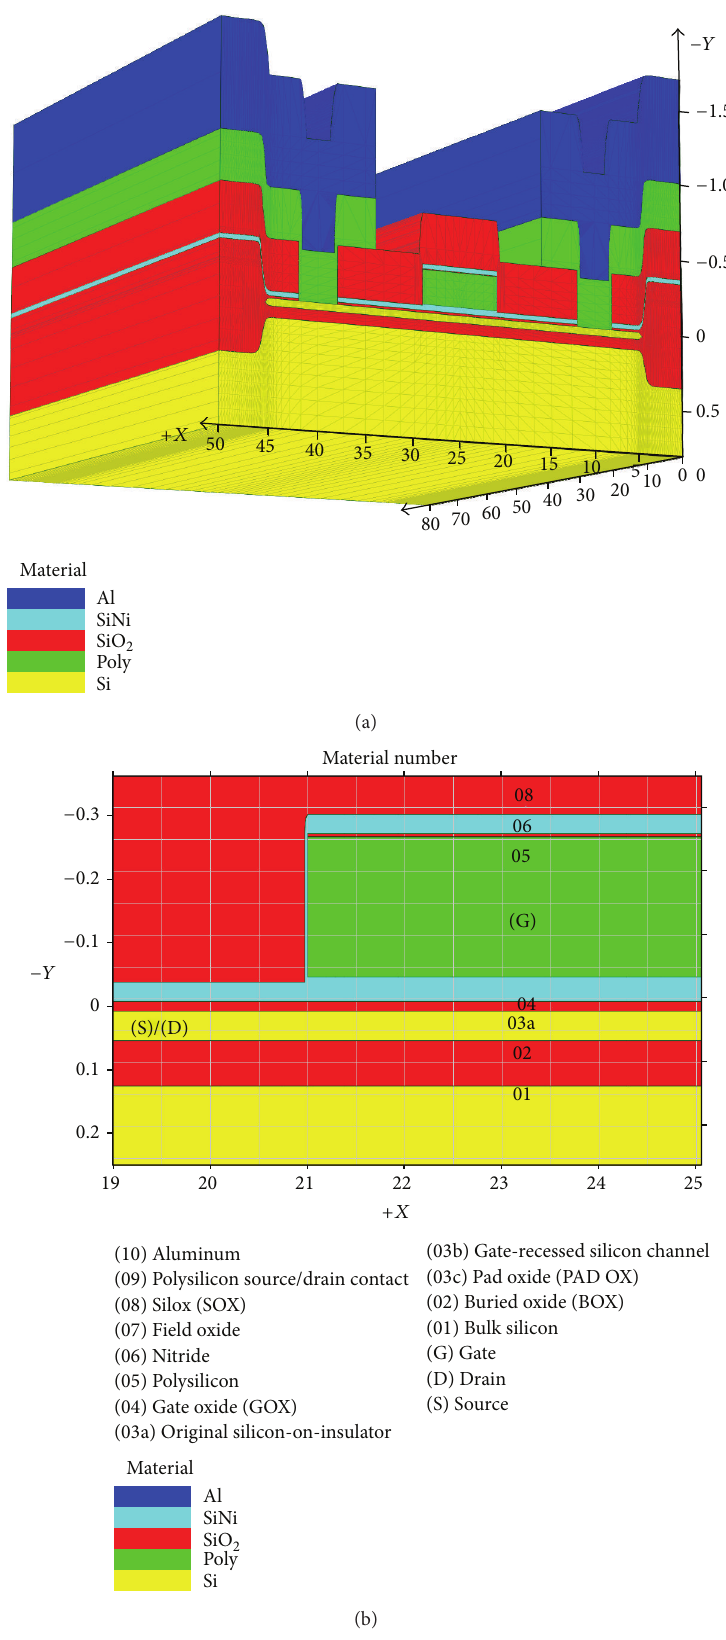
Figure 1: (a) 3D cross view and (b) 2D zoom-in of UTB (46nm thick SOI channel) device, using TCAD process simulation. 𝑋 , 𝑌 , and 𝑍 axes are in micron